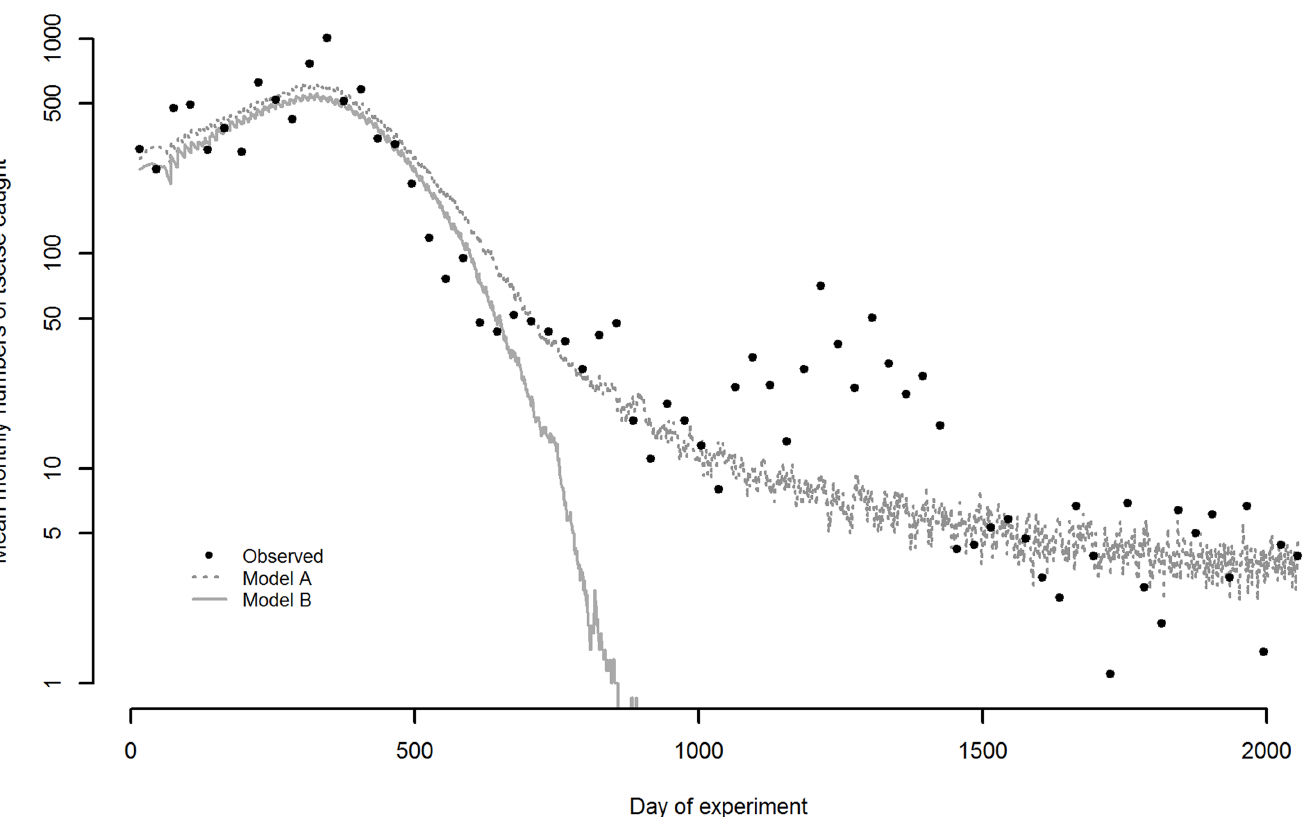
Fig 4. Output from agent-based model (ABM) of tsetse population dynamics including starvation-dependent mortality. Assuming δ = 0.00001, σ = 0.135 and μ b = 0.011. Lines represent the means over 10 model runs. Model A: assumingmovement of flies into and out of the experimental area, with flies moving a straight-linedistanceof 0.5 cells/ 250m per day in a random direction, sum of squaredresiduals– 43. Model B: assuming a closed system with no movement of flies into or out of the experimental area. Sum of squaredresiduals–294. σ is the daily probabilitythat a fly finds, and feeds on a host, given one host is present within a square of side 1 km aroundthe